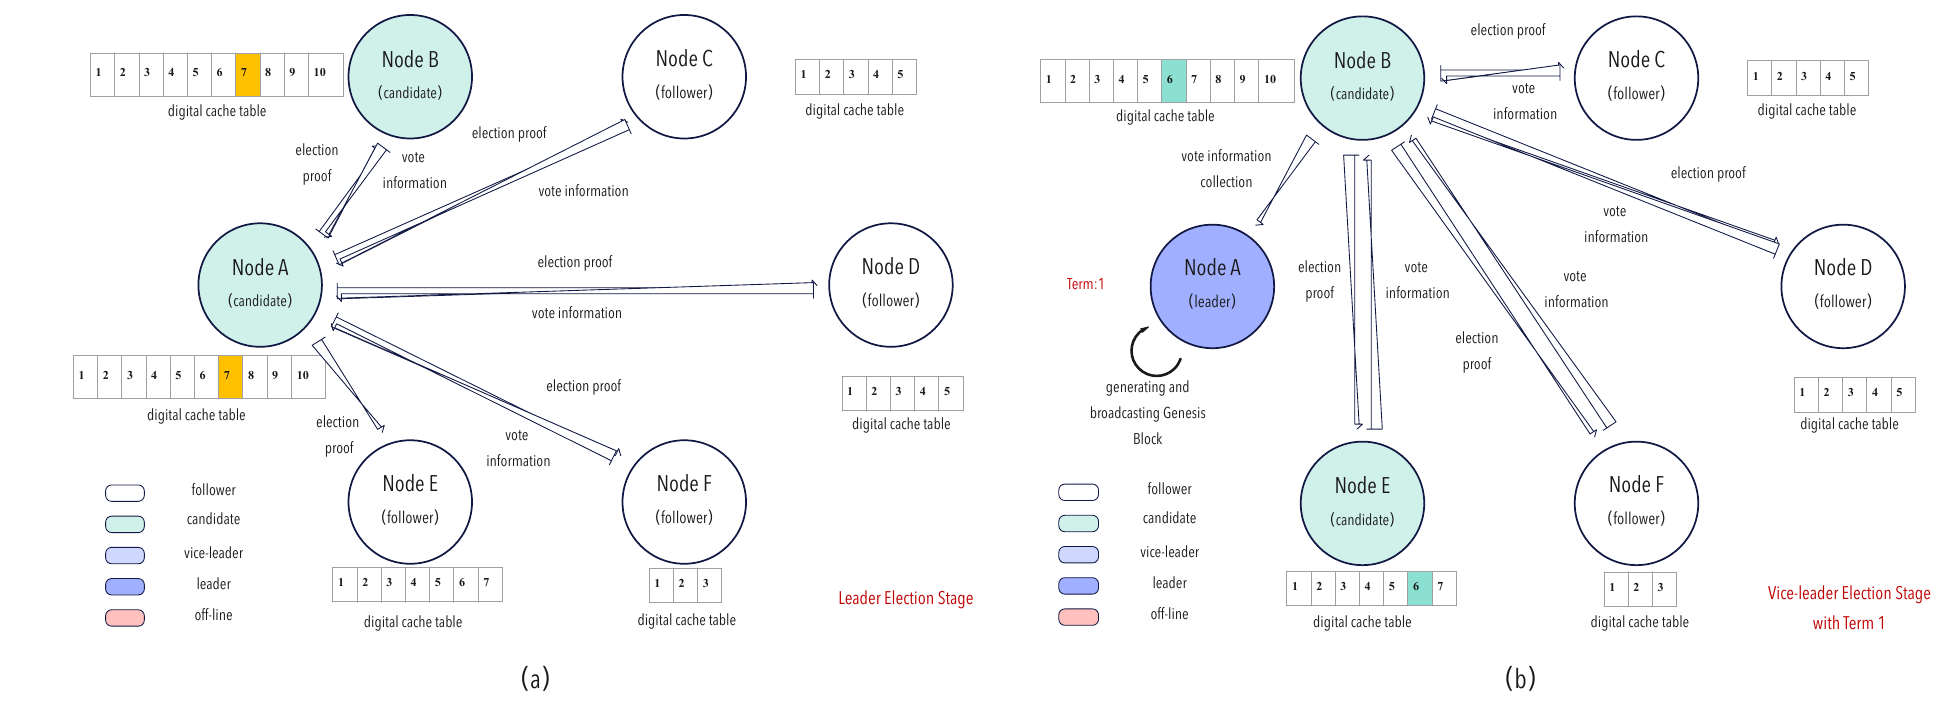
Figure 3. Consensus flow chart: ( a ) LEADER election stage and ( b ) VICE-LEADER election stage with TERM